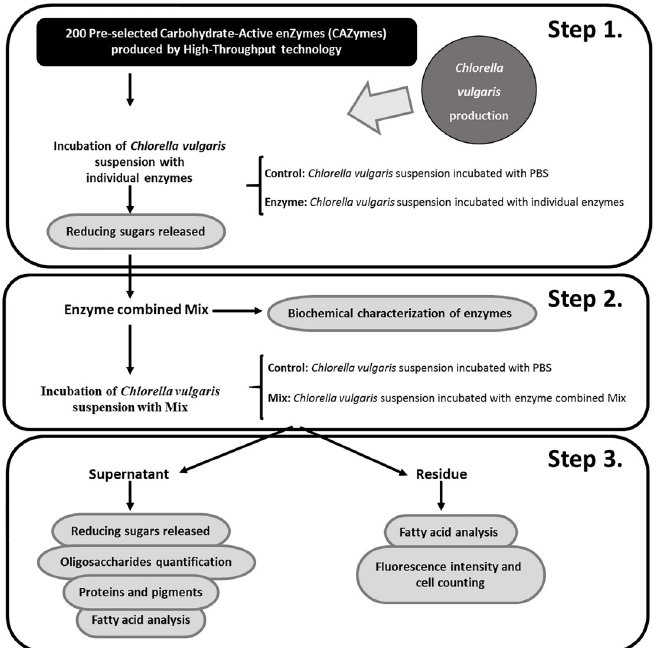
Fig 1. Illustration on the laboratory protocol followed by Coelho et al. [9, 10] to disclosure novel combination of feed enzymes to disrupt Chlorella vulgaris cell wall. Briefly, after Chlorella vulgaris cultivation, this flow chart depicts: as step 1, the individual screening of the most functional enzymes on disrupting Chlorella vulgaris cell wall; as step 2, finding the best CAZymes cocktail to disrupt Chlorella vulgaris cell wall; and as step 3, assessing the degree on Chlorella vulgaris cell wall disruption by measuring the amount of reducing sugars released, fatty acid analysis, oligosaccharides quantification, proteins, pigments with antioxidant function, and fluorescence intensity as well as cell